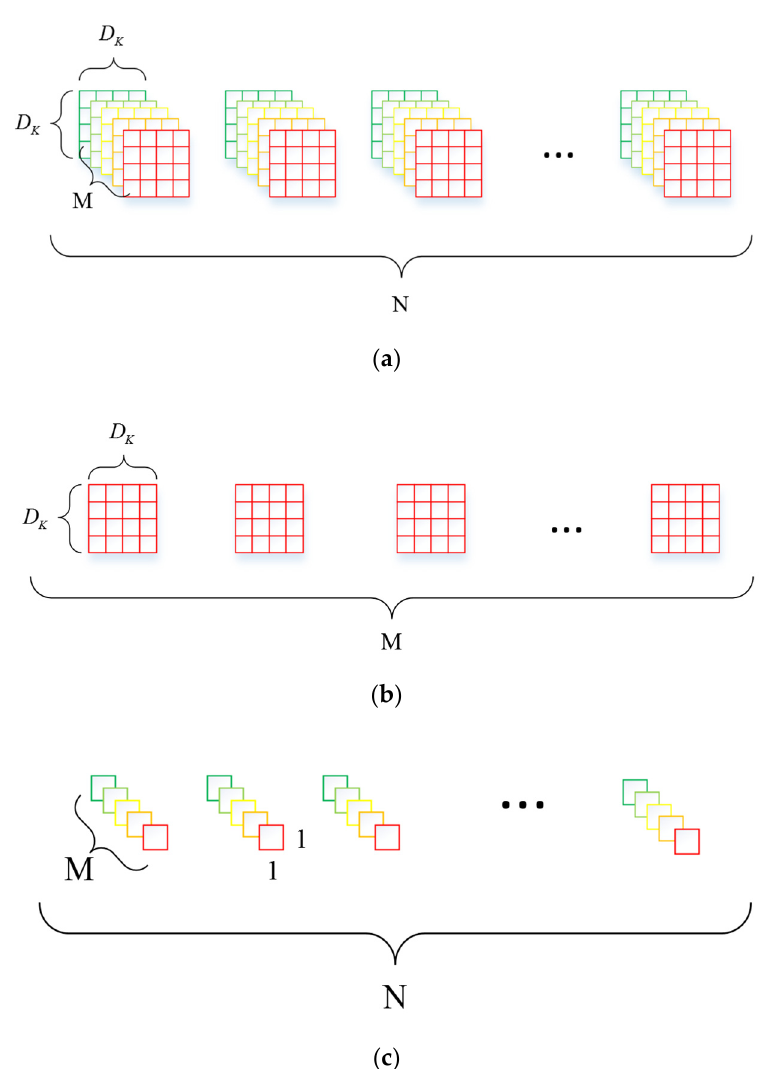
Figure 2. ( a ) Standard convolution kernel; ( b ) Depthwise Convolutional Filters; ( c ) Pointwise Convolutional Filters.